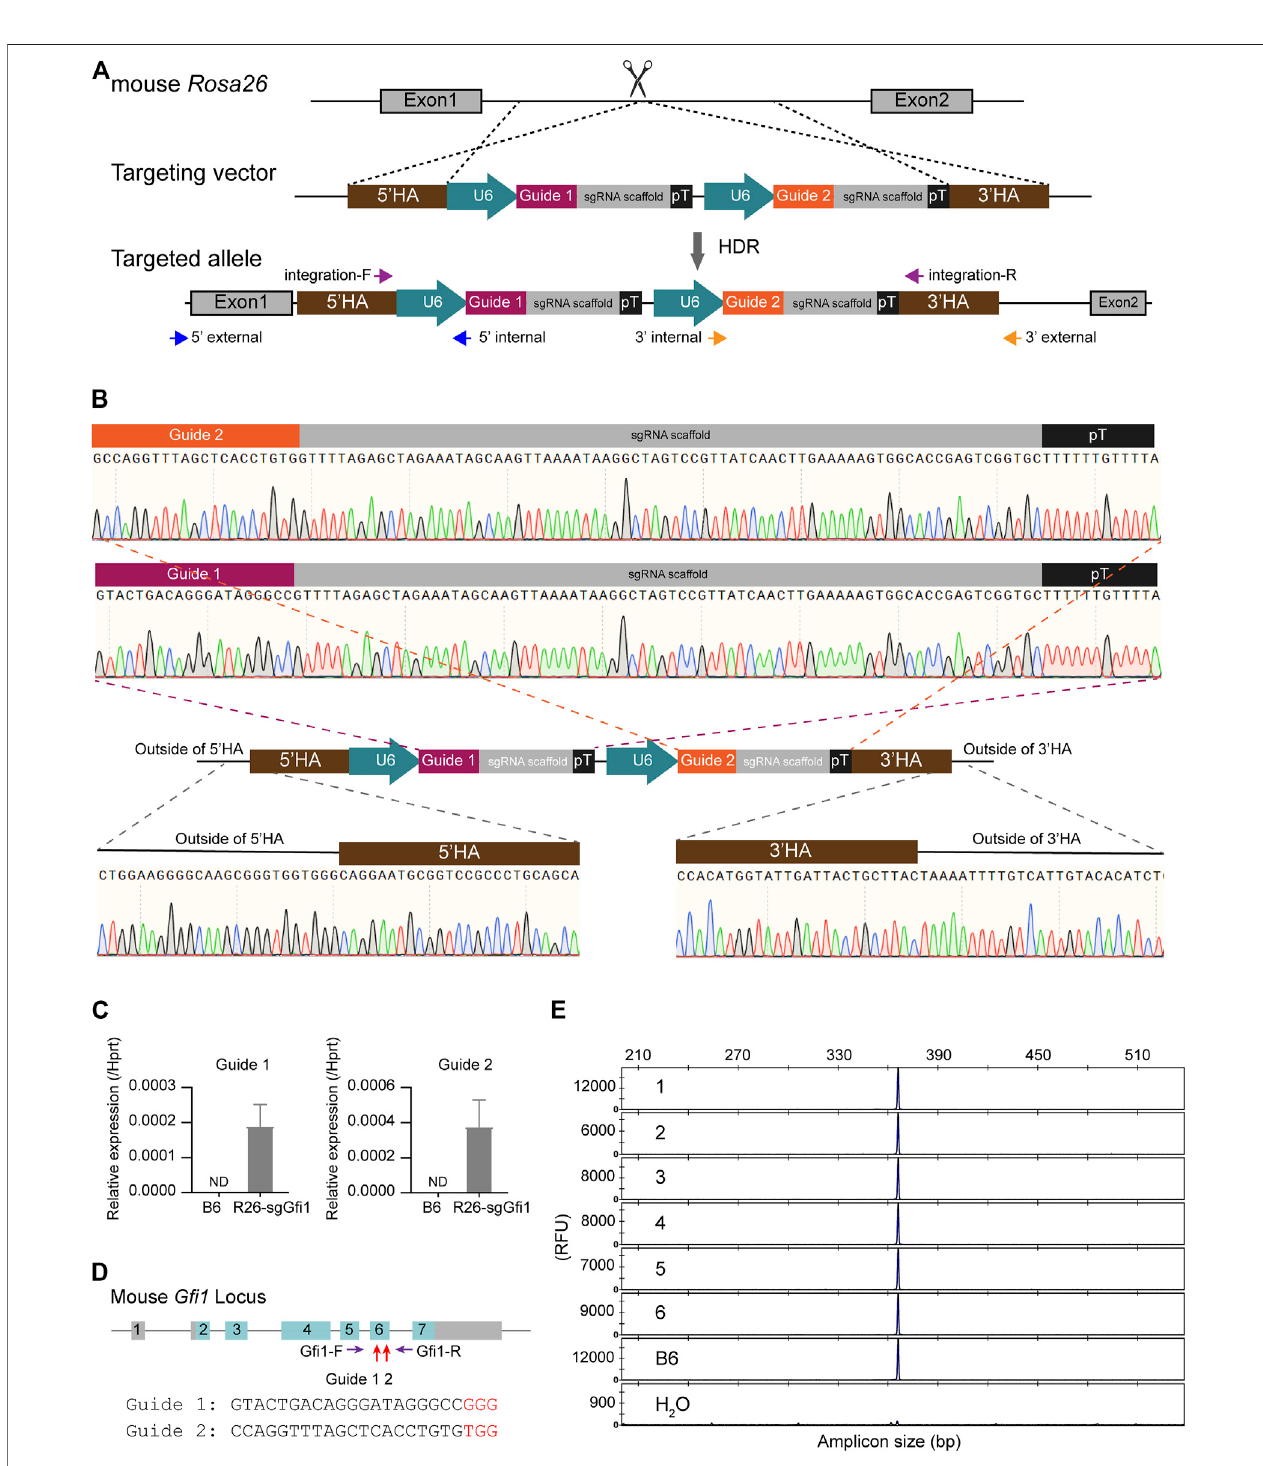
FIGURE 1 | Generation of Rosa26 U6-sgRNA-G fi 1 knock-in mice. (A) Schematic diagram of knock-in of 5 ’ HA-(U6-Guide-sgRNA scaffold-pT) × 2-3 ’ HA vector to mouse Rosa26 locus. U6: RNA polymerase III promoter; pT: polyT signal. (B) Sequencing analysis of junction-PCR products con fi rmed the precise insertion of the two U6-sgRNA units arrayed in tandem into the Rosa26 locus of F0 founders. Chromatographs showed the correct sequences of the two U6-sgRNA cassettes. (C) Assessing the Guide 1 and Guide 2 expression in the Rosa26 U6-sgRNA-G fi 1 (R26-sgG fi 1) embryos using real-time qPCR. B6: two-cell embryos derived from IVF using sperms and eggs of both wild-type B6 mice. ND: not detected. (D) Diagram of the mouse G fi 1 locus. The Guide 1 and Guide 2 target sequences were located withinexon6ofthe G fi 1 gene.Apair ofprimers(G fi 1-Fand G fi 1-R)spannedtheentire exon6and gaveanampliconof368bp. (E) Representative dataofcapillaryarray electrophoresis (CAE) of R26-sgG fi 1 embryos to detect genetic modi fi cation mediated by sgG fi 1 via CRISPR/Cas9. RFU: relative fl uorescent unit.